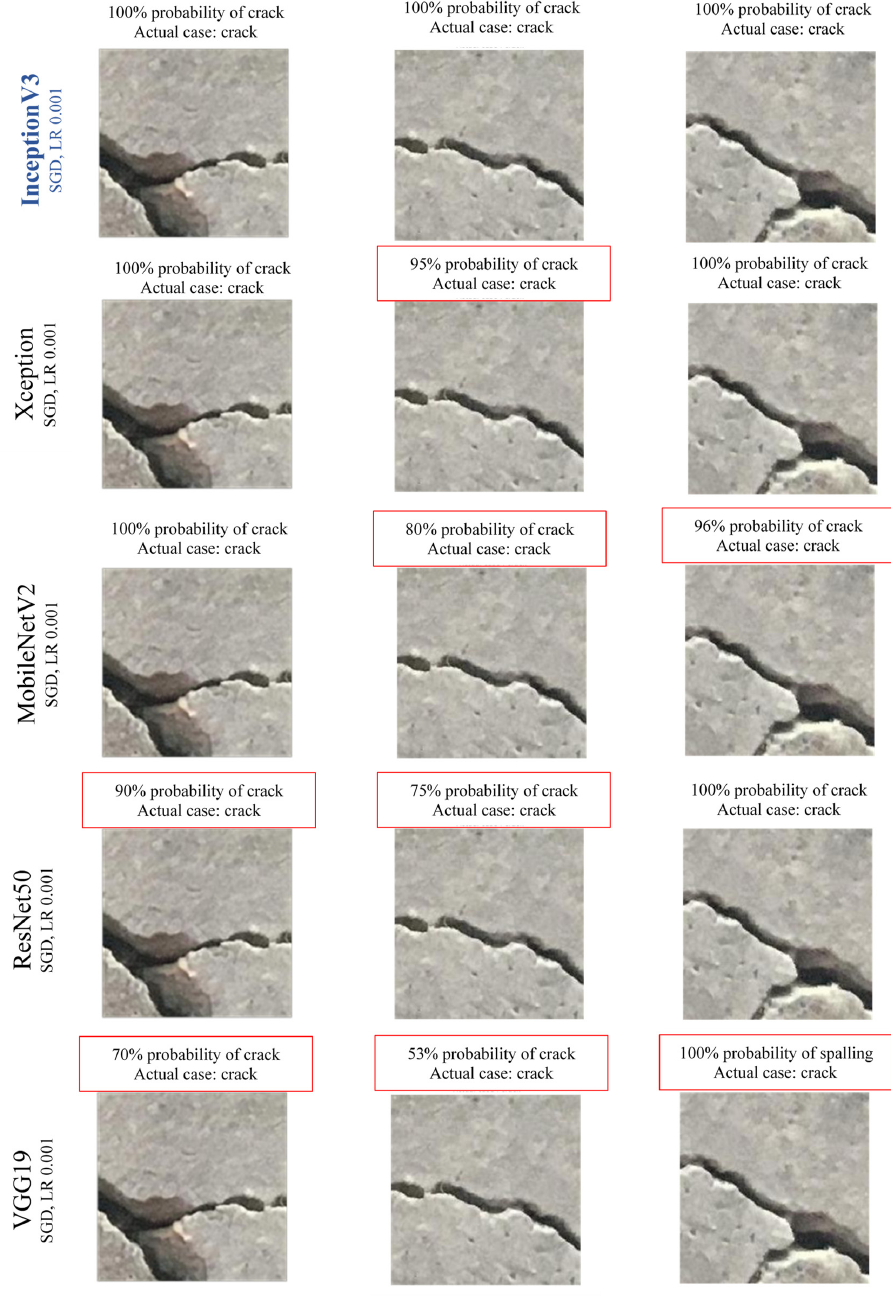
Figure 10. Sample images for crack prediction using CNN models.